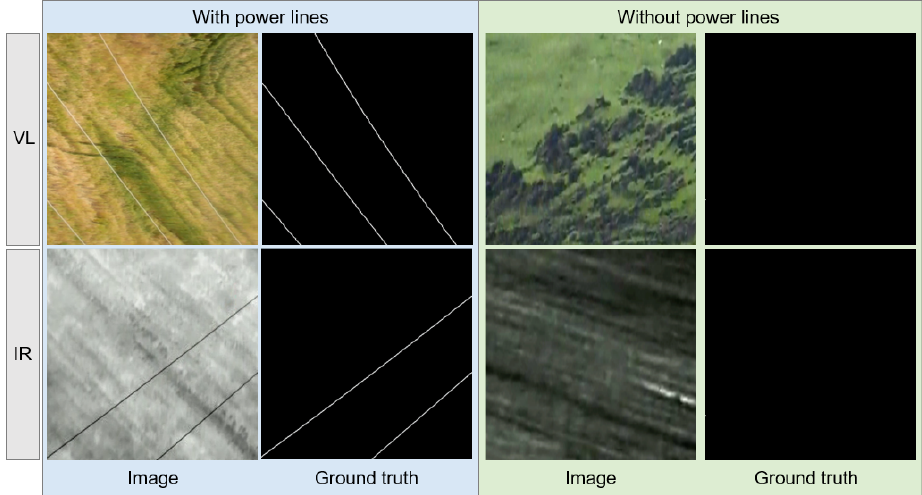
Figure 7. Example images and their corresponding ground truth